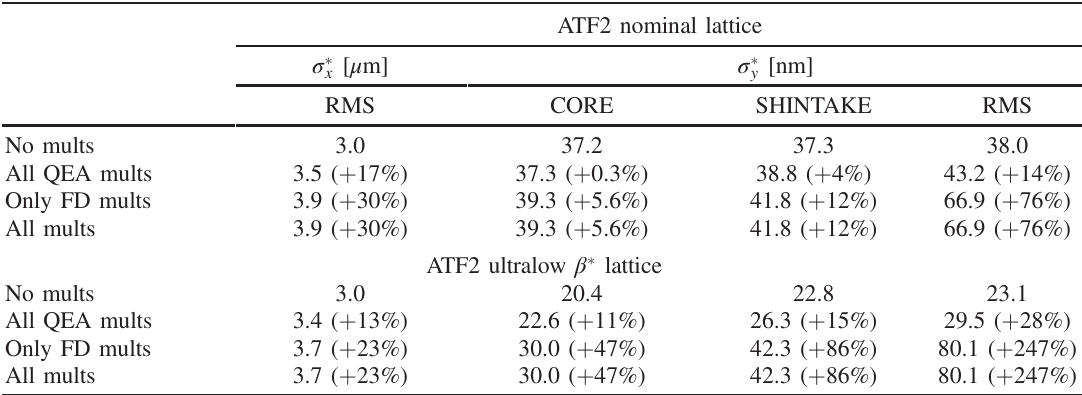
TABLE II. Comparison between the values of the IP beam size obtained, when gradually including the multipole components of the ATF2 magnets, according to the core, Shintake, and rms beam size definitions for the ATF2 lattices. The values shown inside the parentheses refer to the percentage of beam size growth with respect to the beam size for the case where no multipoles are assumed in the simulations.